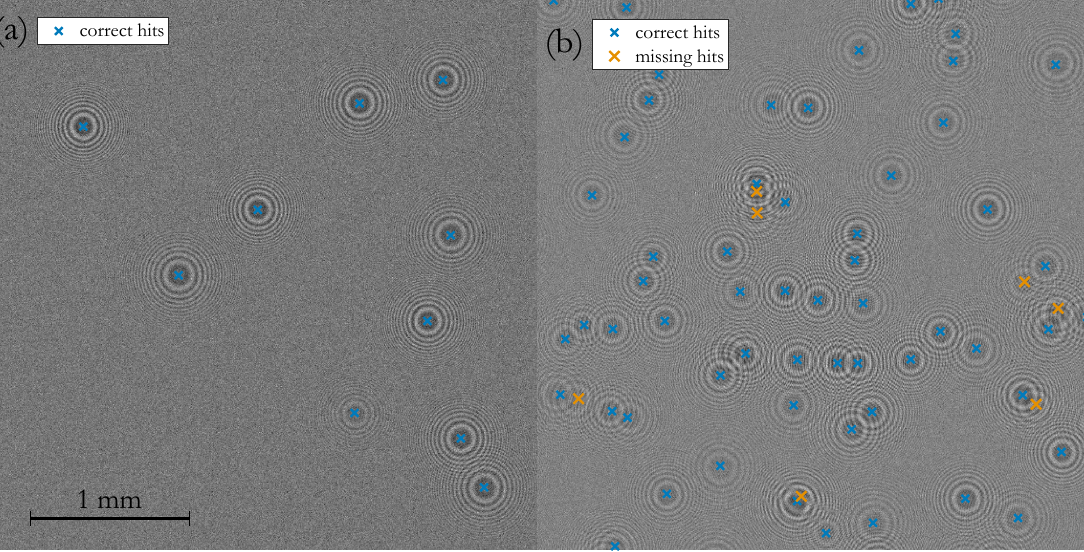
Figure 4. Zoomed segments of frames at: ( a ) low particle density of 78 # and no missing hits; frame ( b ) medium particle density of 273 # with missing hits. Because of intrinsic higher speckle noise in frame the right frame segment, the contrast is lower while the background noise level is